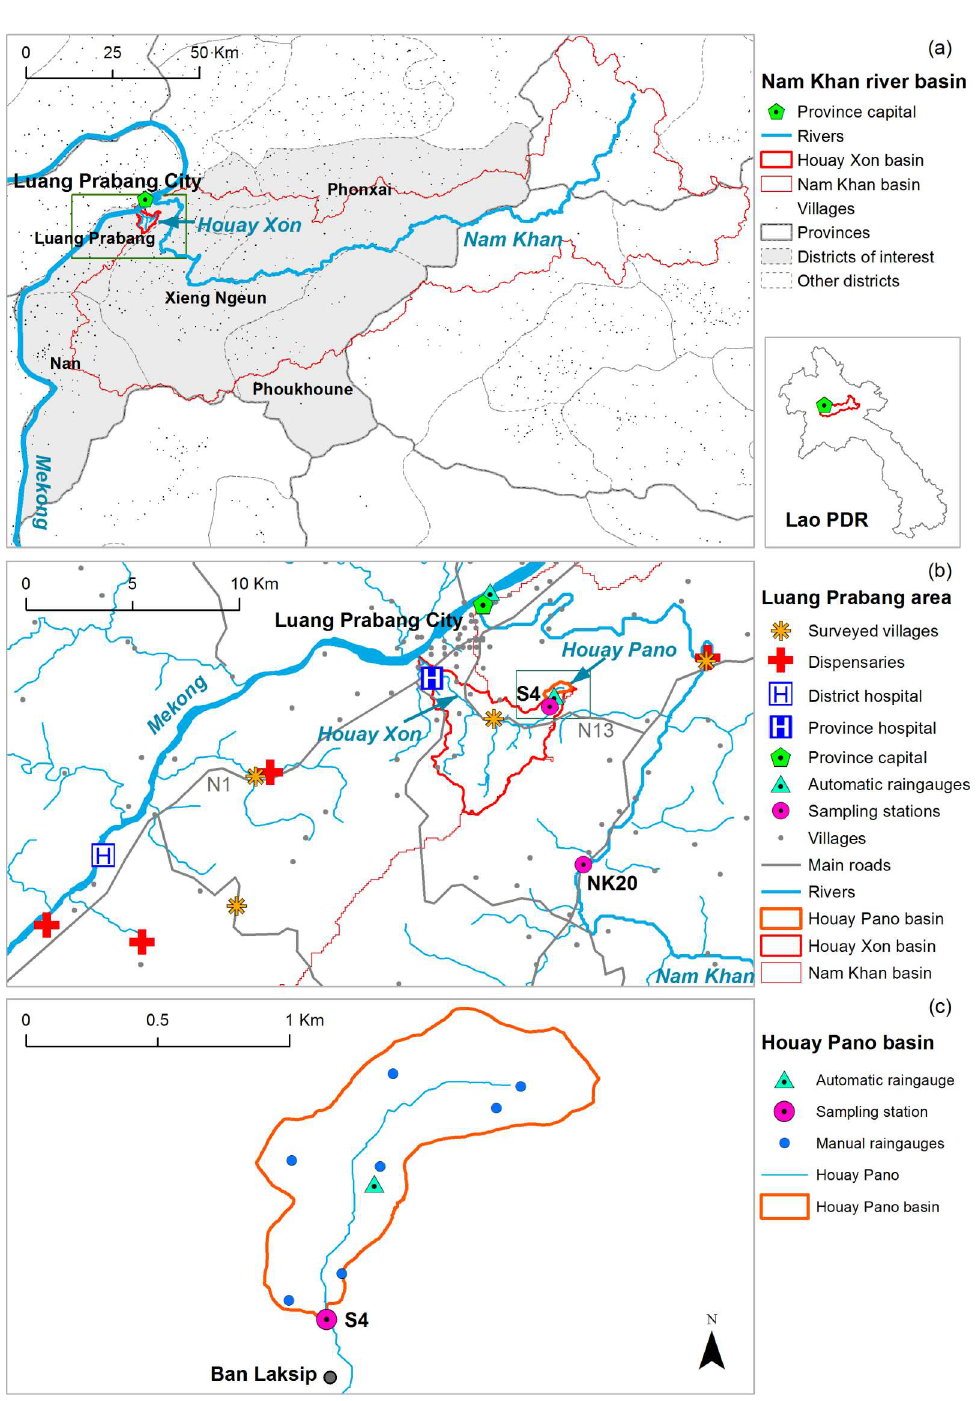
Fig 1. Location of (a) the Nam Khan basin with delineationof the districts of interest in this study, (b) the Luang Prabangarea with Nam Khan, Houay Xon and Houay Pano catchments together with samplingstations S4, NK20 and health centers and villages where sociological surveys were performed, and (c) zoom on the Houay Pano catchment with the location of the villageof Laksip and meteorological stations.